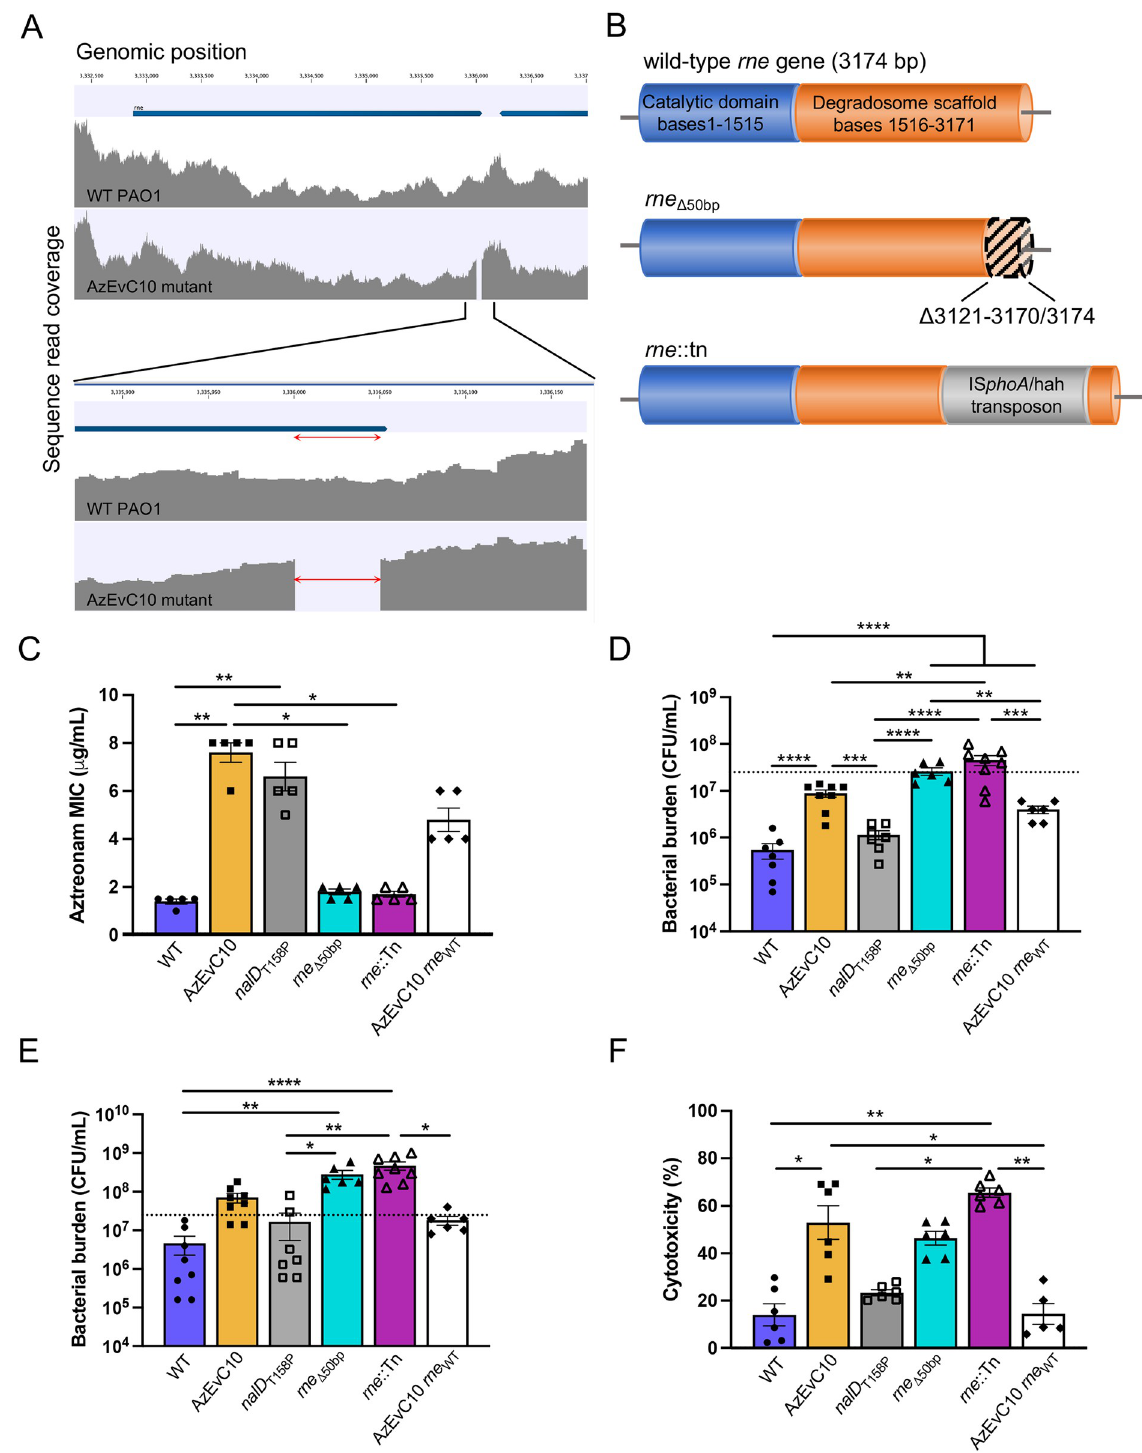
Fig 2. AzEvC10 mutant hypervirulence is caused by an RNase E mutation. A. Genome diagram showing coverage of DNA sequencing reads aligning to the rne gene. The deletion of bases 3121-3170/3174 nt of the rne gene in the AzEvC10 mutant are enlarged in the bottom panel. Genome coverage plots generated from sequencing read alignments to the PAO1 reference genome are indicated in grey. B. Schematic representation of the rne gene and corresponding RNase E protein domain description. WT PAO1, nalD T158P , and AzEvC10 rne WT mutants carry a wild-type rne gene. AzEvC10 and rne Δ 50bp mutants have a deletion of the bases 3121-3170/3174 nt in the rne gene. The rne ::Tn mutant